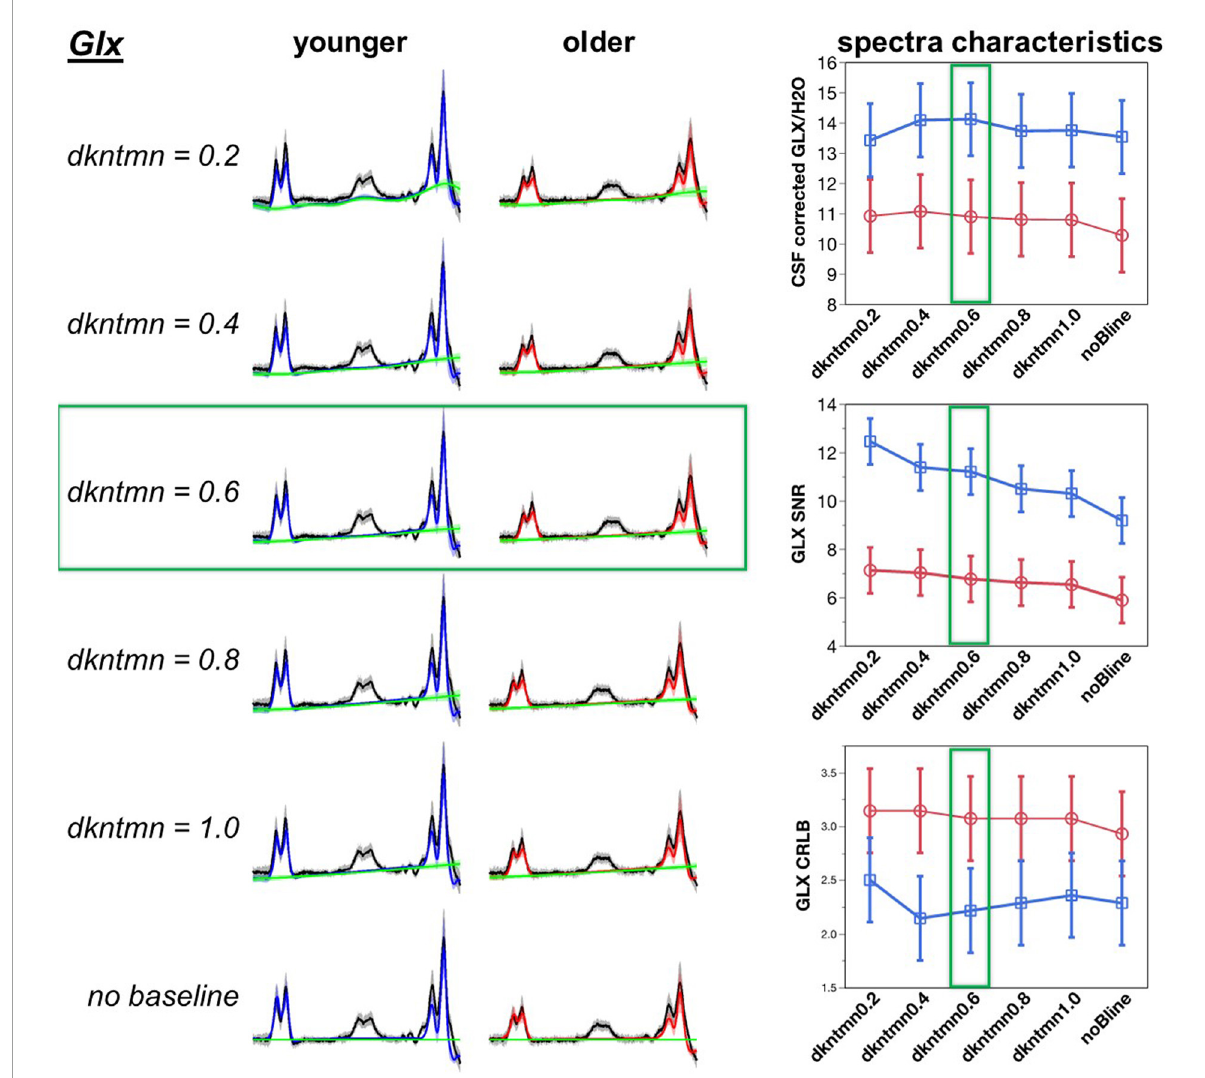
FIGURE4 Optimization of difference signal baseline fitting for Glx. A lower dkntmn indicates a more flexible baseline and higher dkntmn indicates a stiffer baseline. Fitting results for the Glx moiety for dkntmn 0.2–1.0 ppm and no baseline are shown for younger and older cohorts. Black line = average raw spectra, blue = GABA fit for younger, red = GABA fit for older, green line =